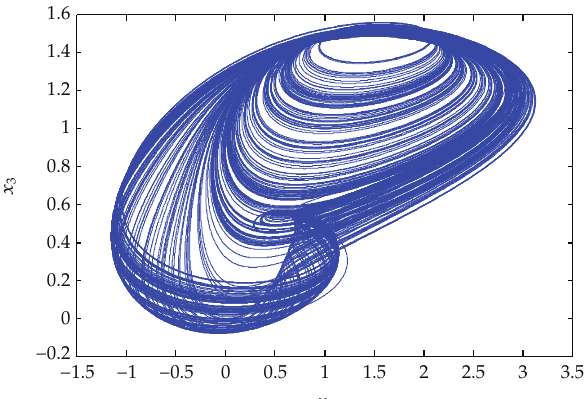
Figure 1: The x 2 - x 3 two-dimensional phase diagram.